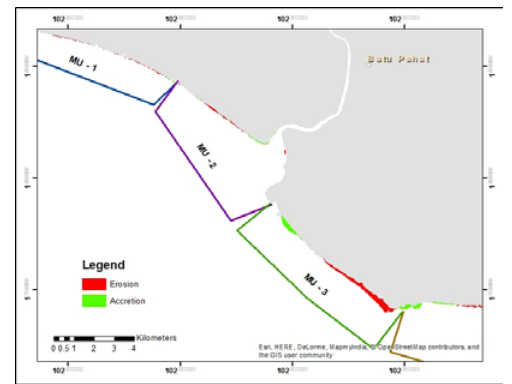
Figure 10. Erosion and Accretion for MU-1, MU-2, and MU-3 Figure 4.2 below show the erosion and accretion for MU – 4. MU – 5, and MU – 6.